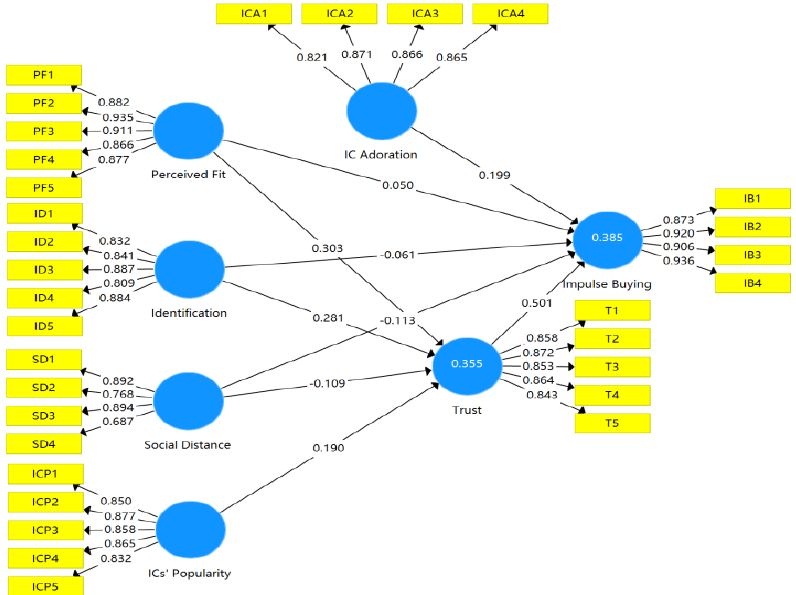
Figure 2. Model resolution by SmartPLS using PLS algorithm.